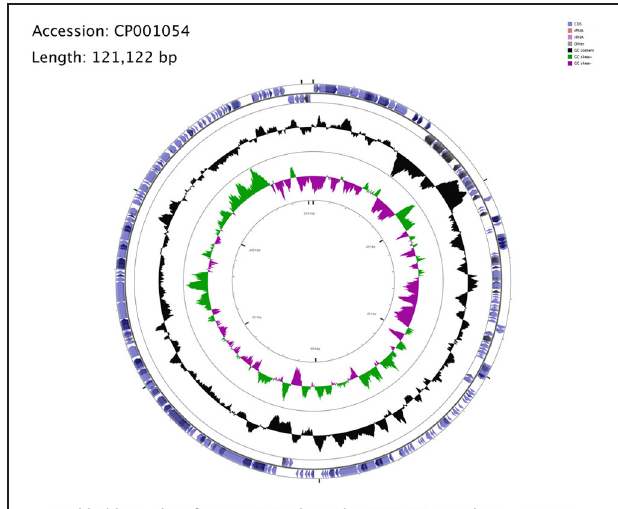
FIGURE 1 | Circular representation of the Burkholderia pyhtofirmans PsJN plasmid pBPHYT01. The illustration is based on the visualization of sequence feature information by the GCView Server http://stothard.afns. ualberta.ca/cgview_server/ (Grant and Stothard, 2008).